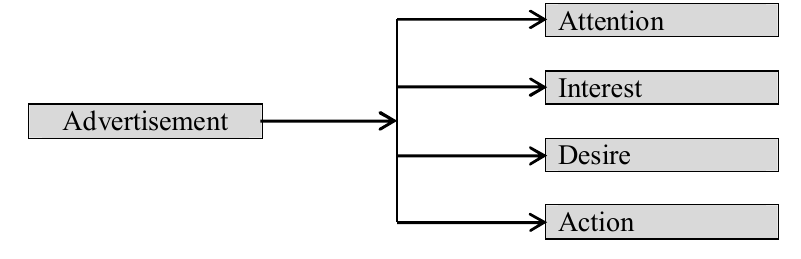
Fig. 1. The proposed AIDA